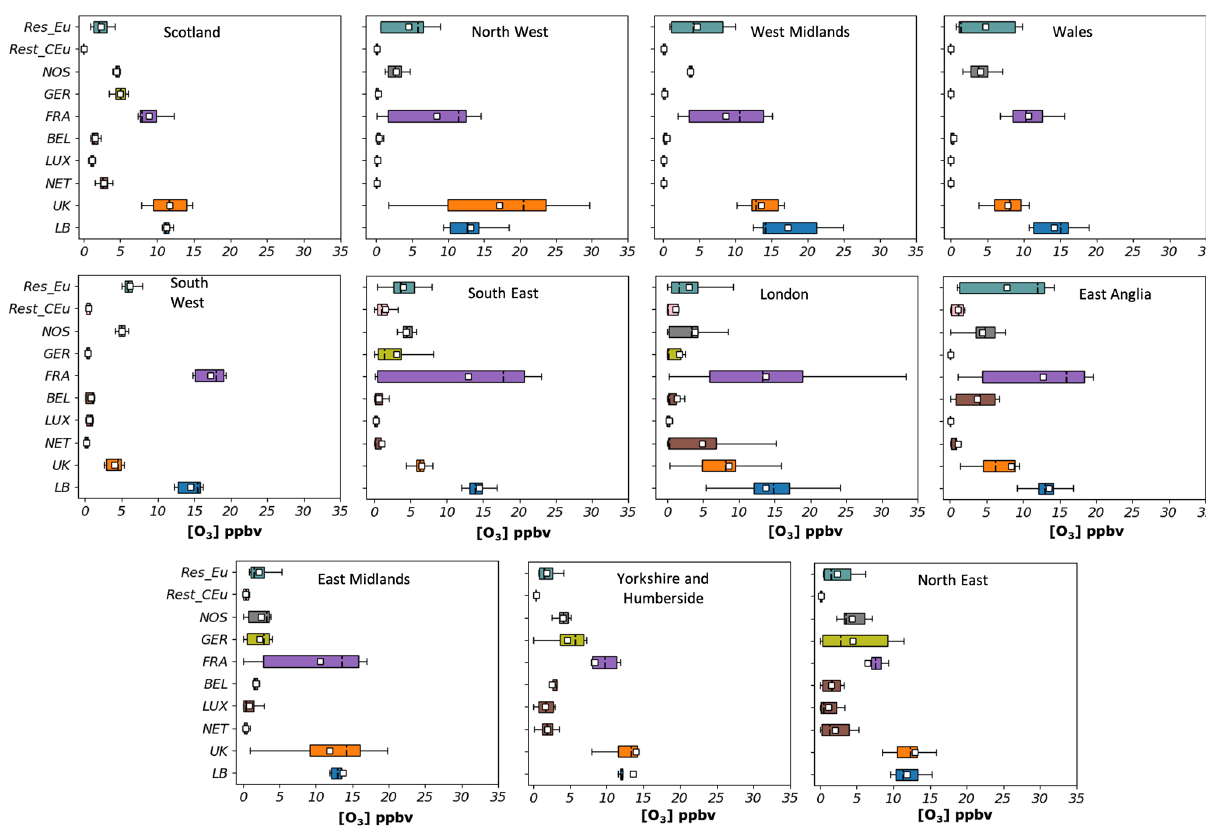
Figure 10. Hourly contributions (in ppbv) to surface O 3 at 11 UK receptor regions from 10 source regions (UK, background (LB), the Netherlands, Luxembourg, Belgium, France, Germany, the rest of central Europe (Rest_CEu), the North Sea and English Channel (NOS), and the rest of Eu) during days when the MDA8 is above 50ppbv between May and August. The lower and upper ends of the boxes indicate the 25th and 75th percentiles, the dashed black line the median, the white boxes the mean, and the whiskers the minima and